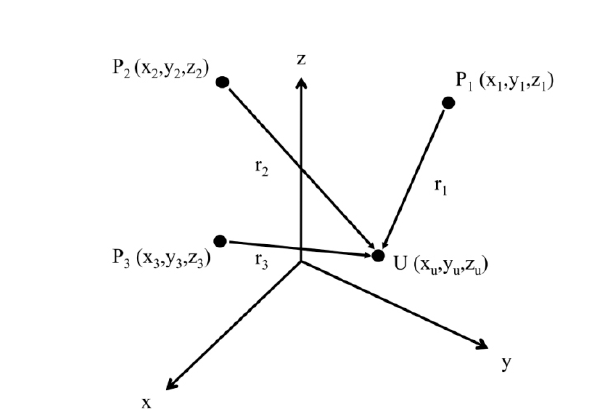
Fig. 1. Two dimensional user postion (Al-salihi 2010) Fig. 2. Three dimensional user position (Al-salihi